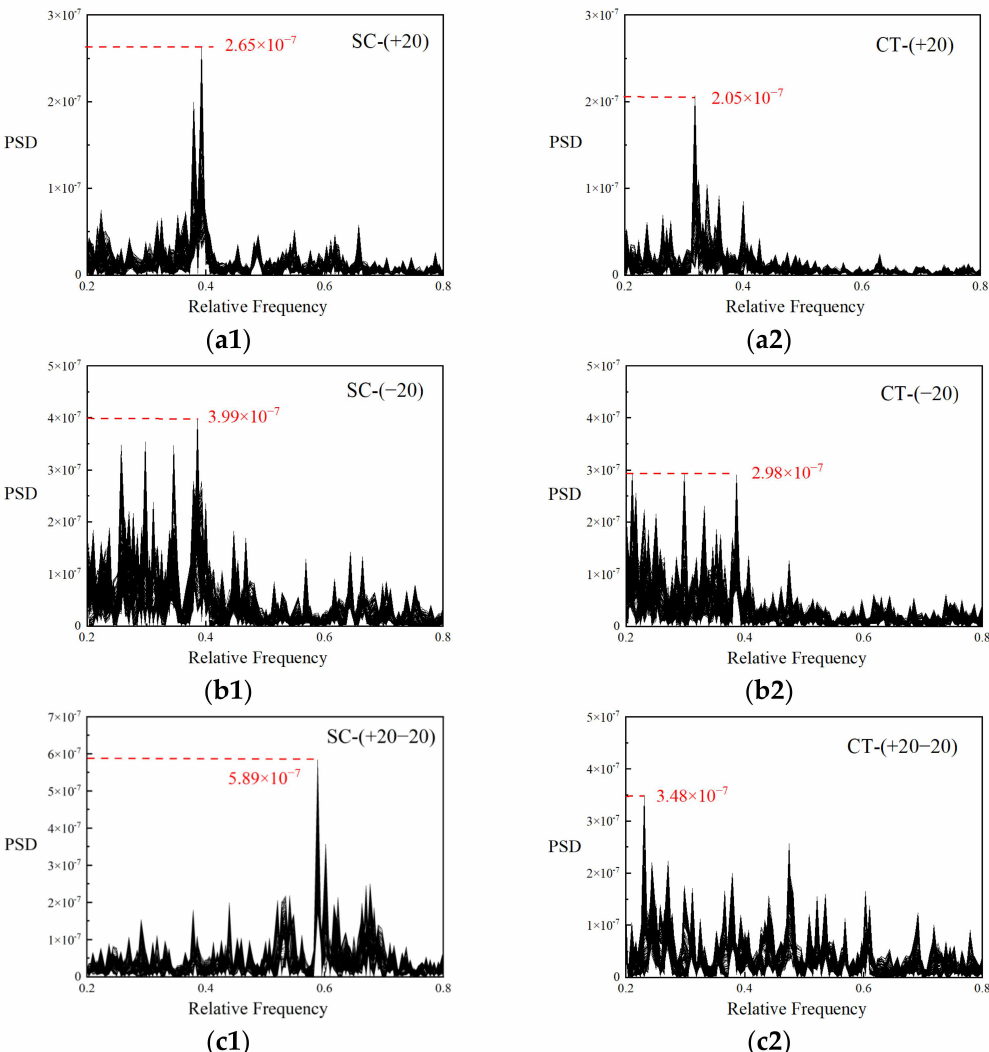
Figure 14. PSD of dynamic pressure signal by normalized frequency without ( 1 )/with ( 2 ) SPS casing treatment under various inlet swirl distortions of ( a ) +20, ( b ) − 20, and ( c ) +20 −